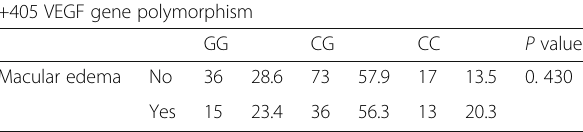
Table 7 Genotype frequency of +405G/C genotype VEGF polymorphism in patients with macular edema +405 VEGF gene polymorphism